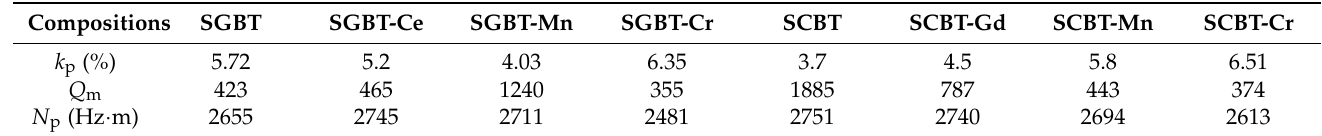
Figure 4. Electro-mechanical resonance spectroscopy of the oxide-modified SBT ceramics at room temperature. Table 3. Electro-mechanical properties of the oxide-modified SBT